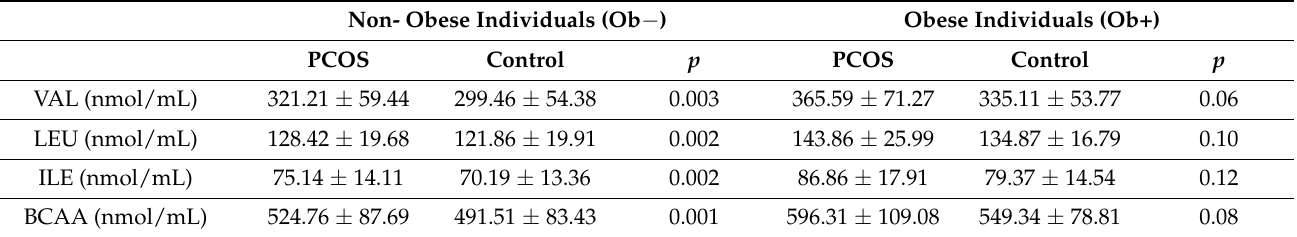
Table 4. Comparison of BCAA profile between PCOS and control groups in the Ob − and OB+